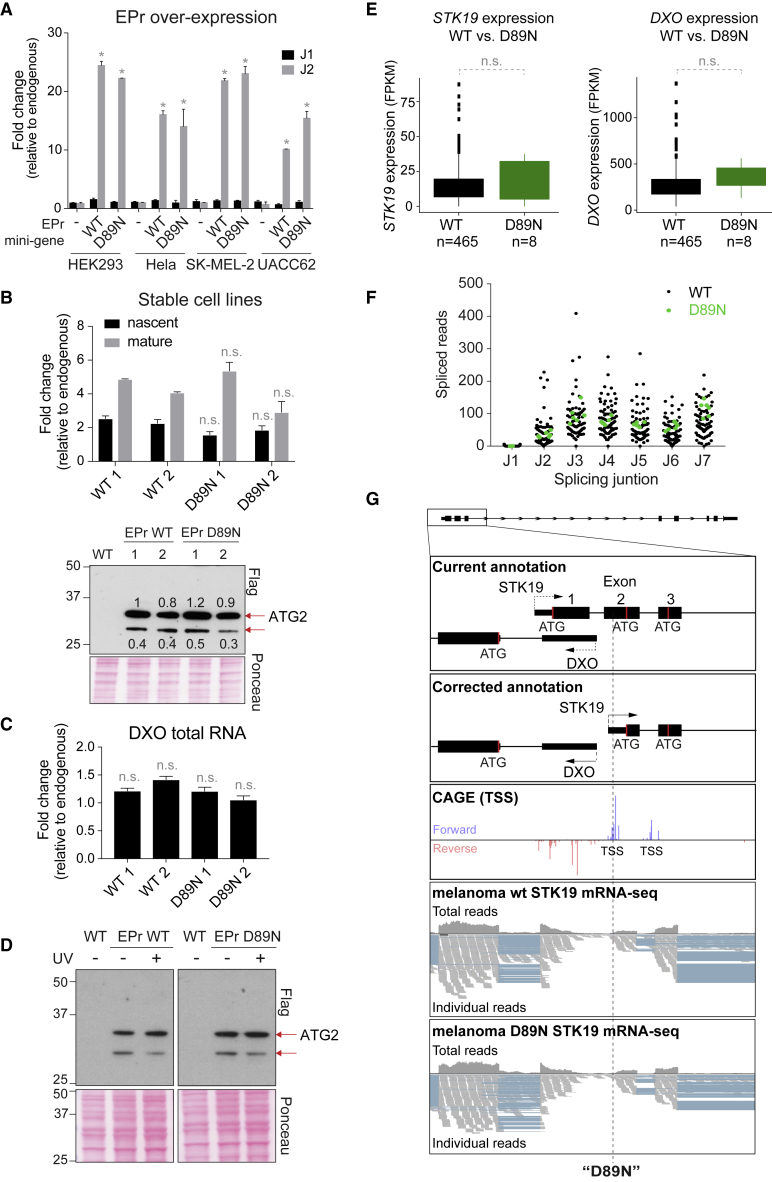
“D89N” Does Not Affect STK19 Expression(A) qPCR of STK19 expression after transient transfection of empty vector, WT or “D89N” EPr constructs (shown relative to endogenous control), comparing splice junction 1 (J1) and 2 (J2) as per the current annotation. Error bars represent ± SD. Statistically significant differences (p < 0.05, multiple t tests, Holm-Sidak correction) of three replicates compared to endogenous non-transfected control are indicated with asterisks. All other differences are not significant.(B) Top: qPCR of STK19 expression in stable cell lines expressing a single copy of EPr WT or EPr “D89N.” Two cell lines of each construct are represented, showing relative expression of mature and nascent RNA compared to endogenous levels. Error bars represent ± SD. “n.s.” indicates non-significant differences compared to EPr WT (multiple comparison test, Holm-Sidak correction). Bottom: western blot of the same cell lines, using Flag antibody. Red arrows indicate the isoforms expressed. Bands at 34 and 29 kDa correspond to expression from the 2nd and 3rd ATG (or possibly a degradation product), respectively. Relative abundance of every band is shown. Ponceau-stained loading control is shown.(C) qPCR measuring DXO expression in cell lines stably expressing a single copy of EPr WT or EPr “D89N” relative to endogenous un-transfected control. Error bars represent ± SD. n.s indicate non-significant difference compared to EPr WT (Multiple t tests, Holm-Sidak correction).(D) Western blot of stable cell lines expressing EPr WT or EPr “D89N,” comparing STK19 expression before and 4 h after UV irradiation. Red arrows indicate the isoforms expressed. Bands at 34 and 29 kDa correspond to expression from the 2nd and 3rd ATG (or possibly a degradation product), respectively.(E) Left, STK19 expression in melanoma patient samples with WT STK19 (n = 81) compared to those containing the “D89N” mutation (n = 6). Difference shown as non-significant (n.s.), Wilcoxon, p = 0.95. Right graph, same as left but for expression of DXO. Differences are not significant (n.s.), Wilcoxon, p = 0.078.(F) Splice read counts for every splice junction (J1 to J7) of mRNA-seq of patient samples with WT STK19 (black dots) and “D89N” STK19 (green dots). J1 counts in “D89N” samples is zero.(G) Diagram of STK19 focusing on the 5′ region of the gene. From top to bottom, current annotation, corrected annotation, CAGE data, mRNA-seq data of a STK19 WT melanoma cell line followed by a melanoma cell line containing “D89N” mutation. The location of “D89N” is shown by a dashed line (see also Figure S4).